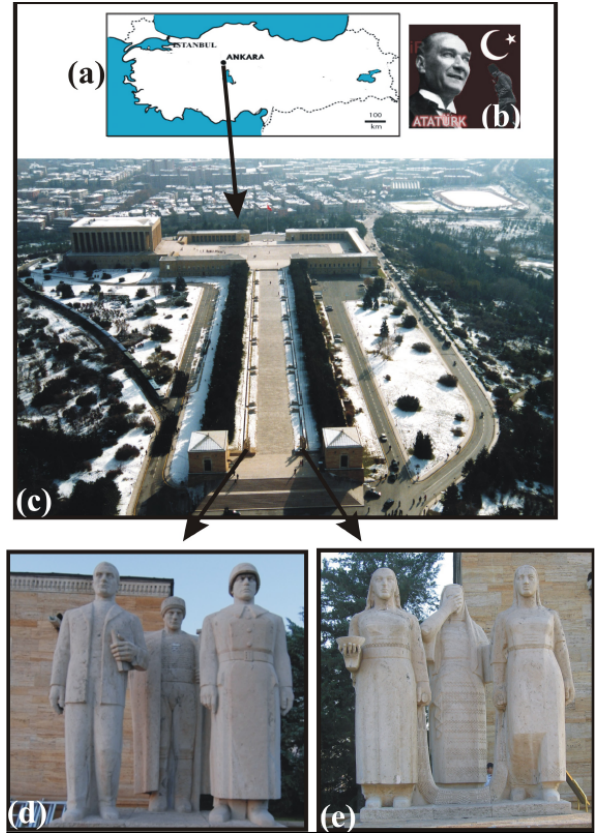
Fig. 1. (a) Location map of the study area, (b) the monument AN- ITKABIR, Ankara-Turkey, (c) Three colossal men statues at the beginning of the Lion Road, which is the entrance to Anitkabir, on the left side, (d) Three colossal women statues at the beginning of the Lion Road across the man statue